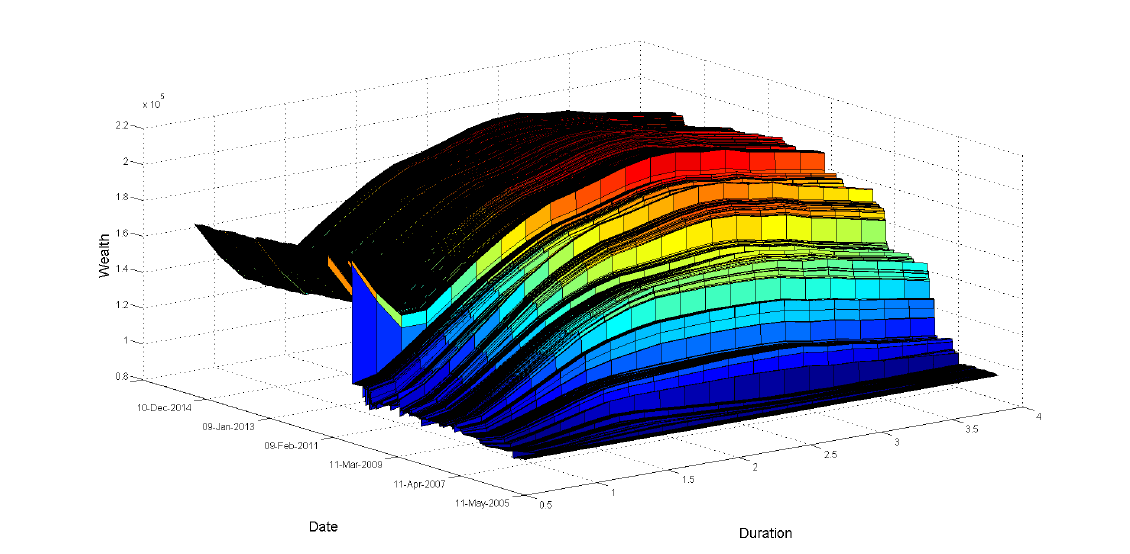
Figure 4. Ex-post wealth on Chinese bond portfolios after first phase (May 2011–April